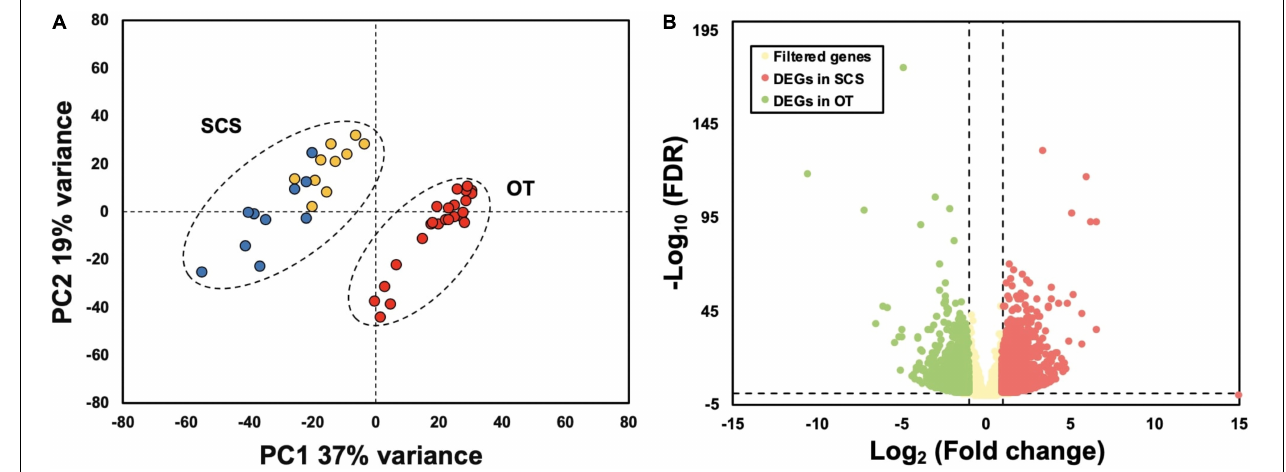
FIGURE 1 | (A) Principal component analysis (PCA) based on gene expression matric of all individuals shows complete separation between individuals from the South China Sea (SCS) and the Okinawa Trough (OT). Red dots indicate samples collected from the OT, and yellow and blue dots indicate samples collected from SCS in 2013 and 2018, respectively. (B) Relationship between FDR and fold change. Red and green dots represent up-regulated genes in the SCS and the OT, respectively. Yellow dots indicate non-DEGs. Vertical dotted lines: log 2 (Fold change) = 1 and –1; horizontal dotted line: –log 10 (FDR) = 0.05.